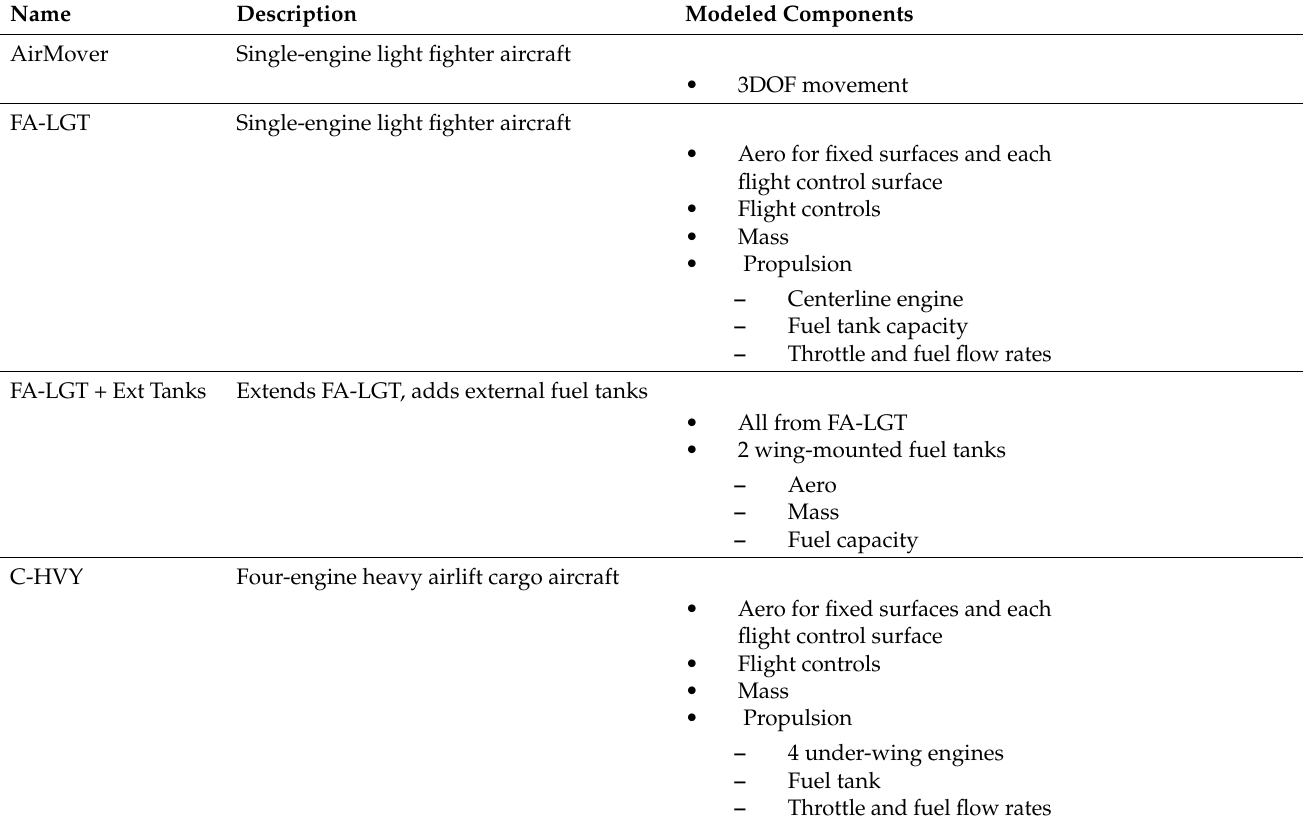
Table 4. Select examples from the AFSIM release.